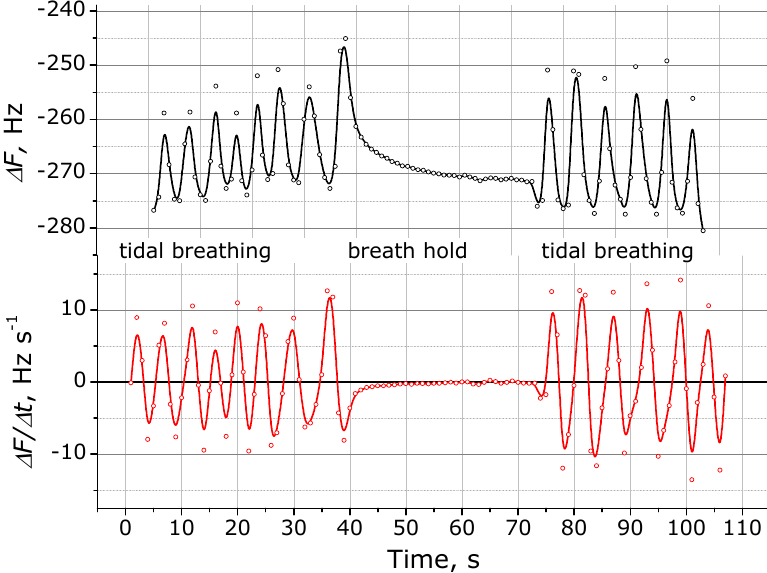
Figure 7. Response of the QCM sensor modified with a (PDDA + /TSPP − ) respiration (upper plot) and the first derivative of signal to normal human breathing with the breathing hold for approximately 30 s (bottom